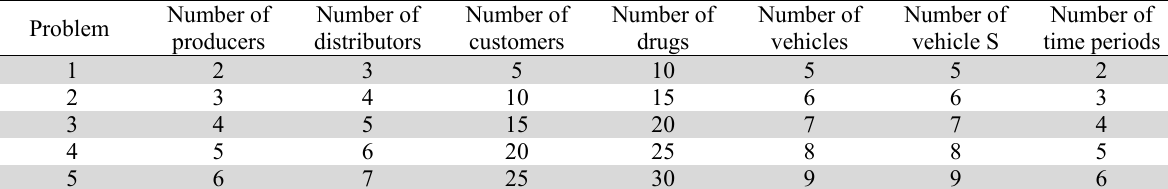
Results of numerical example